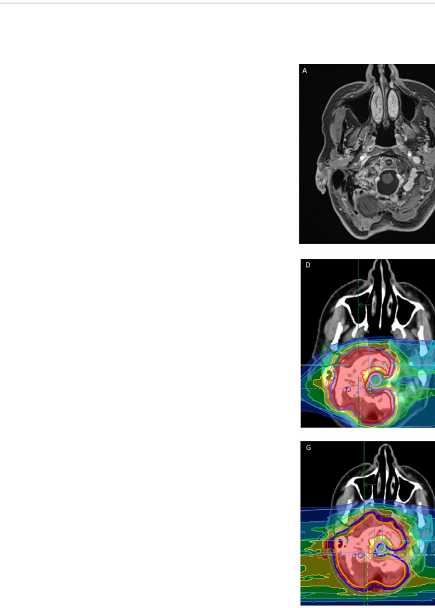
FIGURE 1 Examples of craniofacial osteosarcoma treated by combined ion-beam radiotherapy. (A – C) Representative contrast-enhanced T1 MRI sequences of inoperable craniofacial osteosarcoma. (D – F) Target volume delineation and dose distribution of the according carbon ion boost (18 GyRBE in six fractions). (G – I) Target volume delineation and dose distribution of the according proton base boost (54 GyRBE in 27